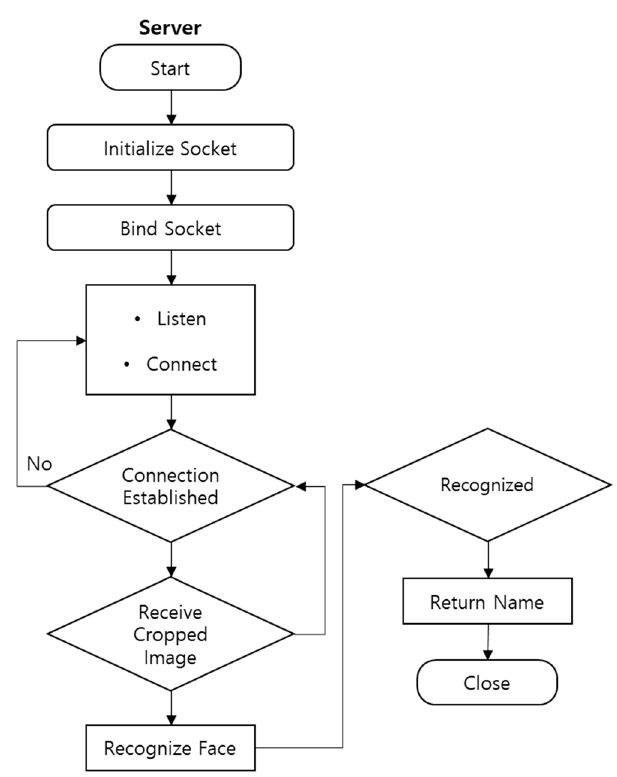
Figure 3. Cloud-based face recognition.